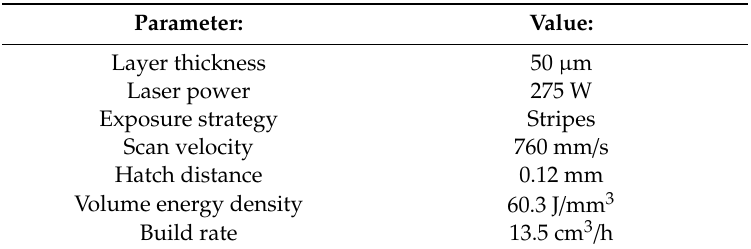
Table 2. Laser powder bed fusion (LPBF) process parameters. Parameter: Value: Layer thickness